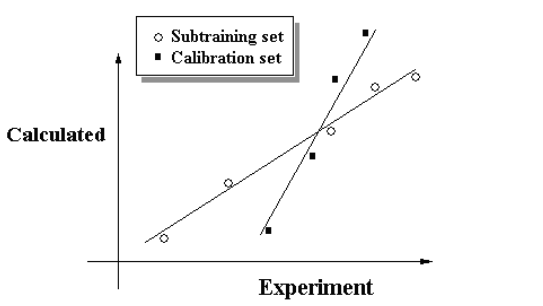
Figure 1. Good correlations which are accompanied by different slopes for the sub-training set and the calibration set in plots of experiment versus calculated values of an